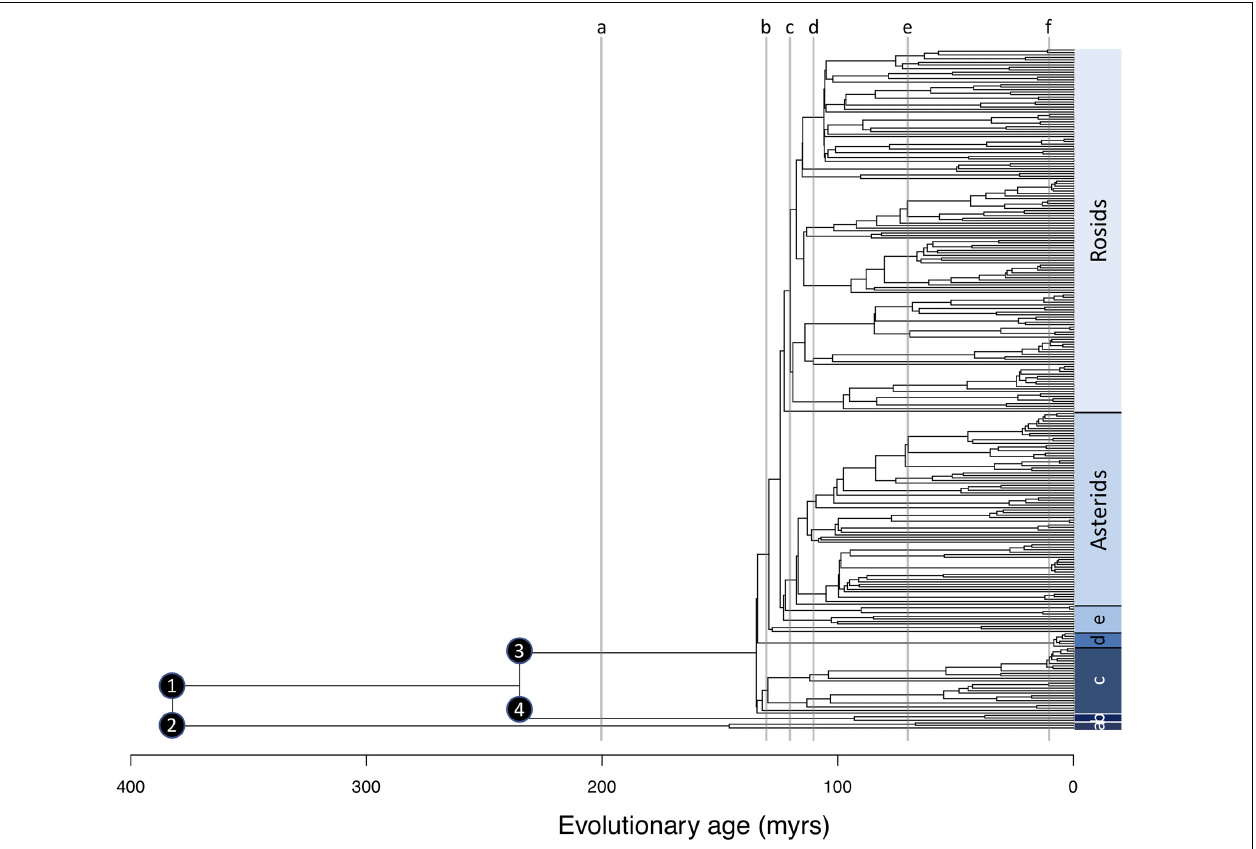
FIGURE 1 | Genus level phylogeny for 275 genera occurring across 23 plots along an elevation gradient from 425 to 3,625 m asl. Numbered nodes relate to lineages mentioned in the text: 1 = seed plants, 2 = tree ferns, 3 = angiosperms, 4 = gymnosperms. Gray vertical lines relate to evolutionary depths of 10, 70, 110, 120, 130, and 200 myrs with letters relating to the panels presented in Figure 3 . Major lineages are indicated in a bar on the right where a = tree ferns, b = gymnosperms, c = Magnoliids and Hedyosmum , d = Monocots, and e = basal